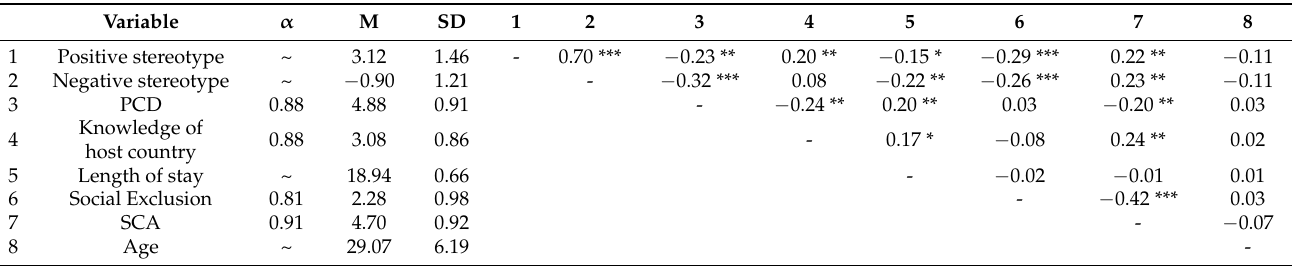
Table 2. Descriptive statistics and correlations.